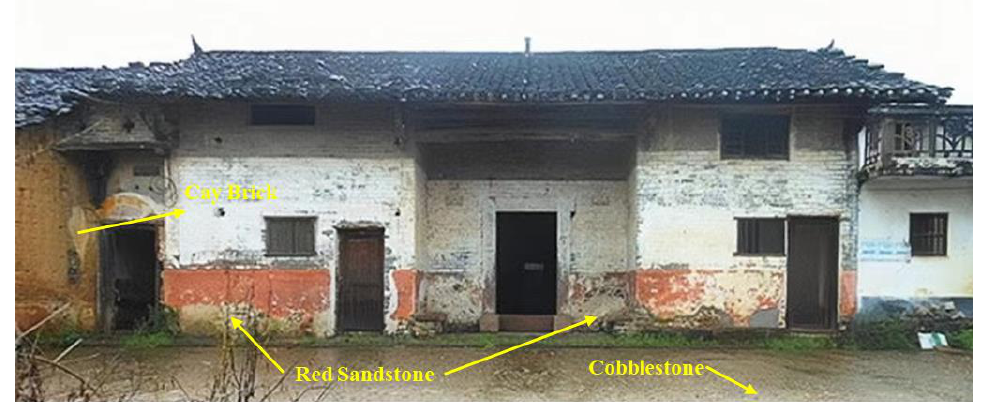
Figure 5. Structural materials of traditional buildings in Donghuping, Shixing.